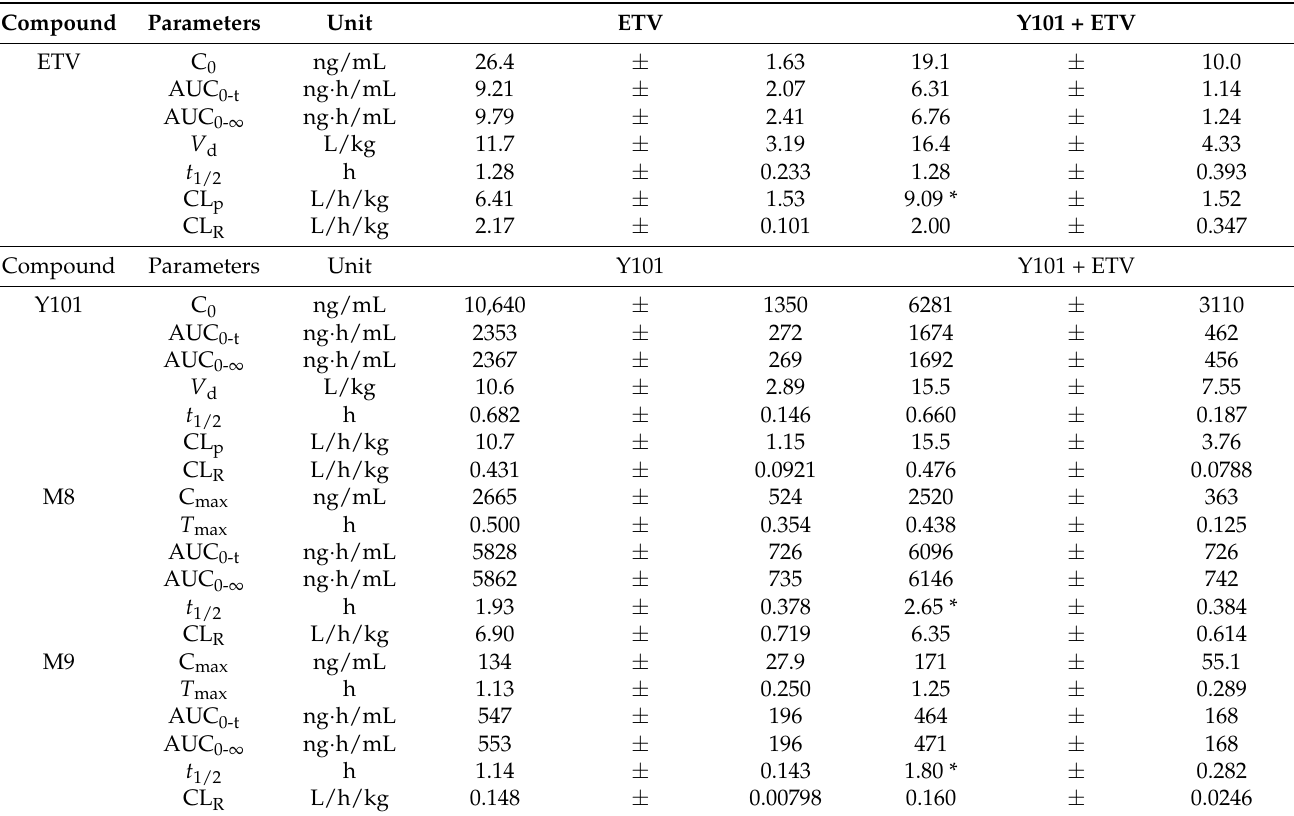
Figure 4. Mean plasma concentration–time curves of ETV ( A ), Y101 ( B ), M8 ( C ) and M9 ( D ) after oral administration of Y101 (60 mg/kg) and Y101 + ETV (0.06 mg/kg). Data are expressed as mean ± SD (* p < 0.05 vs. Y101 group; n = 4). Table 2. Pharmacokinetic parameters of ETV, Y101, M8 and M9 after intravenous administration